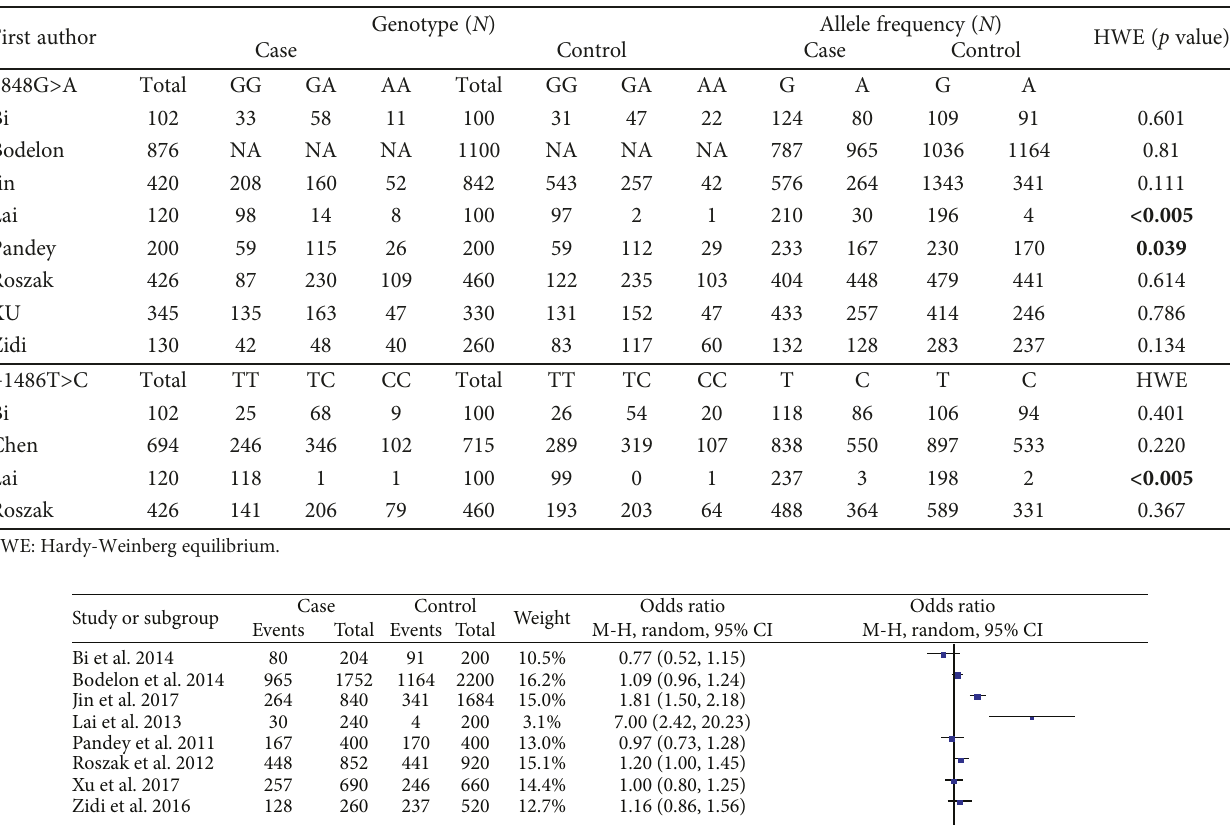
Table 2: TLR9 polymorphism genotype distribution and allele frequency in cases and controls.